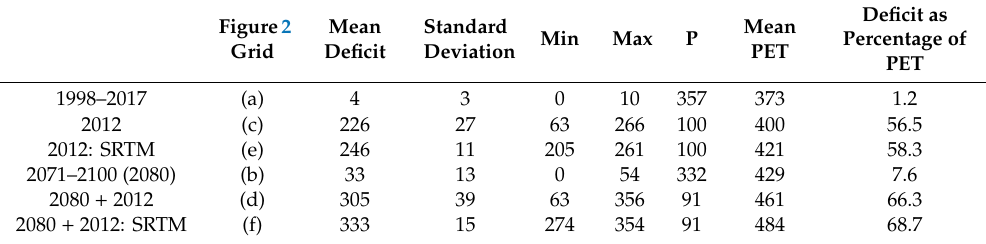
Table 1. Descriptive statistics for summer [JJA] water deficit, precipitation (P), and potential